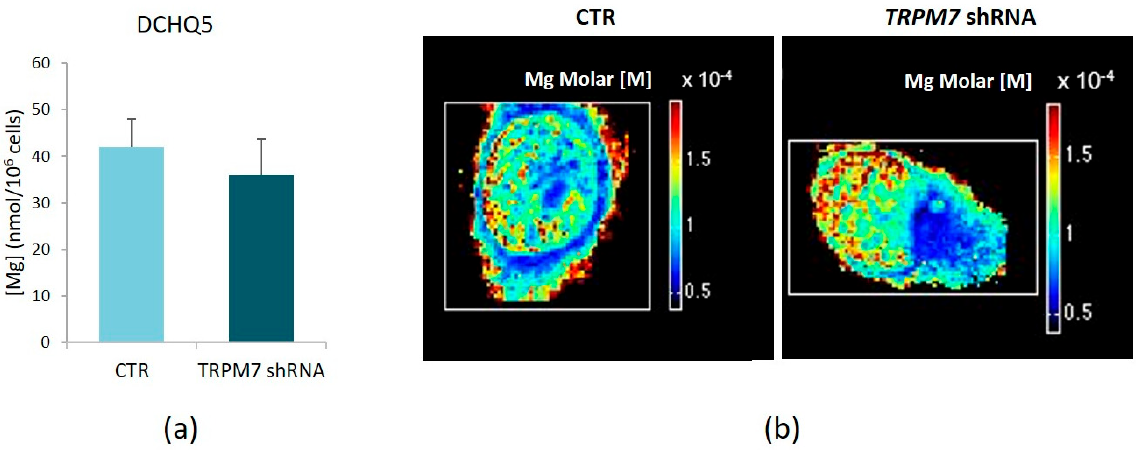
Figure 6. Total Mg concentration and distribution in TRPM7-silencing HUVEC. ( a ) Total Mg in TRPM7-silencing/-expressing HUVEC (TRPM7 shRNA and CTR, respectively) was measured using the fluorescent chemosensor DCHQ5. Data were normalized on cell numbers and expressed as the mean ± SD. ( b ) Elemental nanoscale maps of molar concentration of Mg obtained by single cells analysis is reported. A representative image is shown.